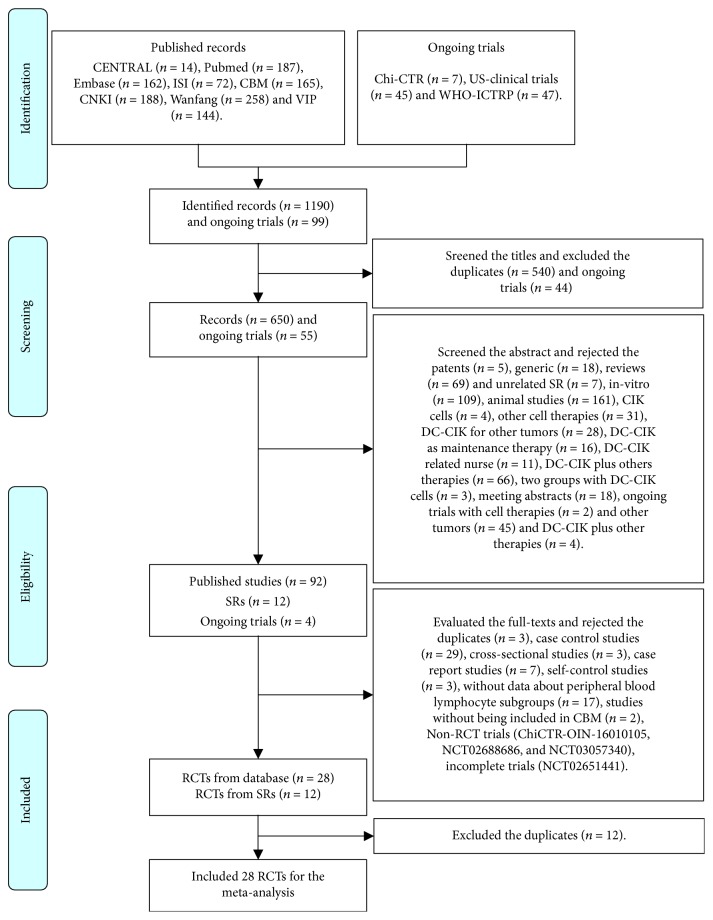
Articles retrieved and assessed for eligibility.